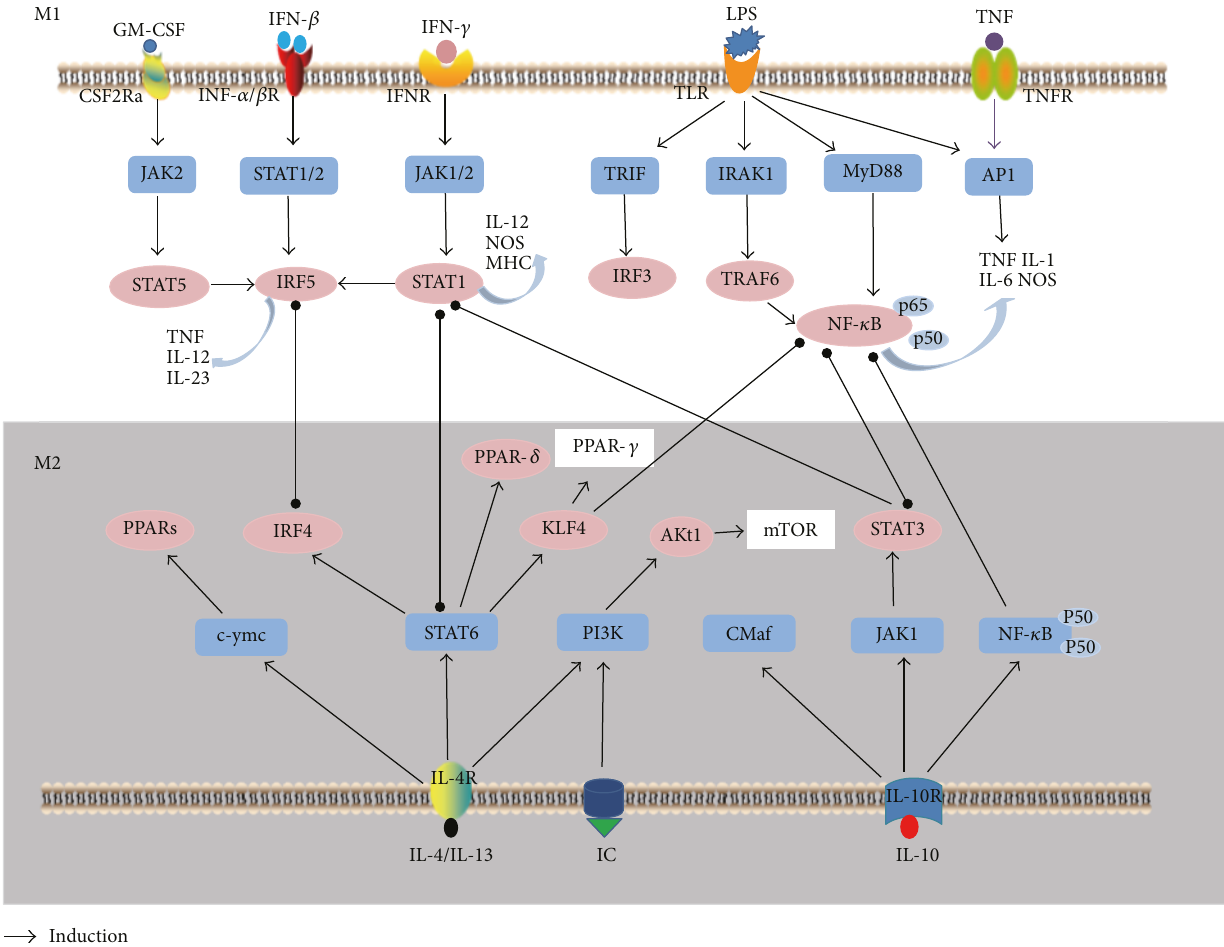
Figure 2: Major signaling pathways involved in M1/M2 polarization. M1 macrophage polarization is mainly induced by granulocyte- macrophage colony-stimulating factor (GM-CSF), interferon (IFN), lipopolysaccharide (LPS), and tumor necrosis factor (TNF), which activate the Janus Kinase/signal transducer and activator of transcription/myeloid di ff erentiation factor 88/nuclear transcription factor- κ B (JAK/STAT/MyD88/NF- κ B) signaling pathways, which lead to the production of proin fl ammatory molecules such as inducible nitric oxide synthase (iNOS), TNF- α , interleukin- (IL-) 1, and IL-6. IL-4, IL-10, IL-13, and immune complexes (IC) induce M2 macrophage polarization by activating STAT6 and phosphatidylinositide 3-kinases (PI3K) signaling pathways resulting in the upregulation of peroxisome proliferator-activated receptor- (PPAR-) δ / γ and anti-in fl ammatory cytokines (IL-10 and tumor growth factor (TGF)- β